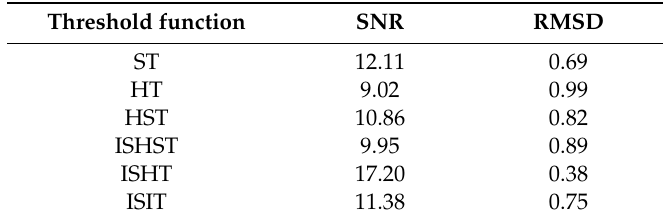
Table 1. Signal-to-noise ratios (SNRs) and root mean square difference (RMSDs) for the different threshold functions.